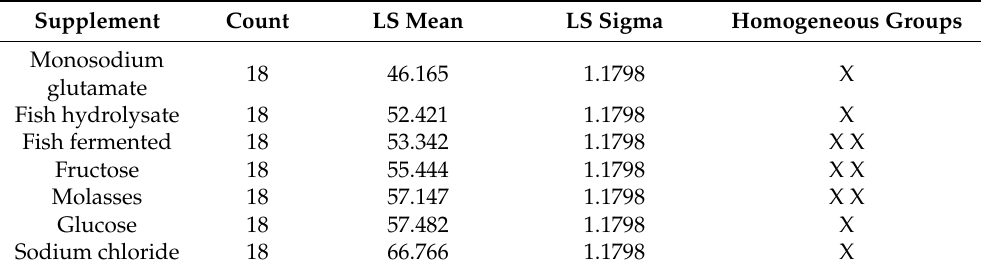
Table 2. Multiple range tests for the diameter (mm) per supplement used in quinoa flour-based culture